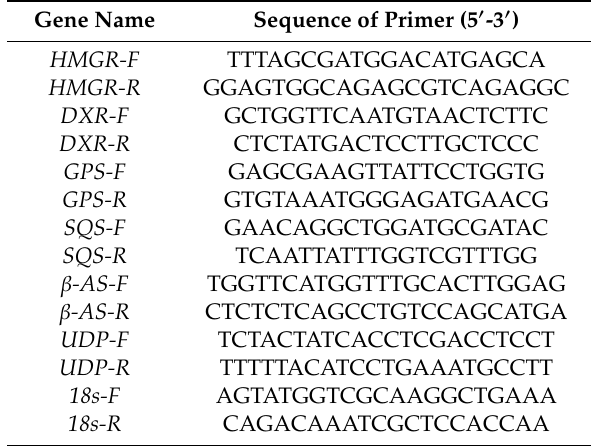
Table 1. Primers used in quantitative real-time polymerase chain reaction (qRT-PCR) in this study. Gene Name Sequence of Primer (5 (cid:48) -3 (cid:48)